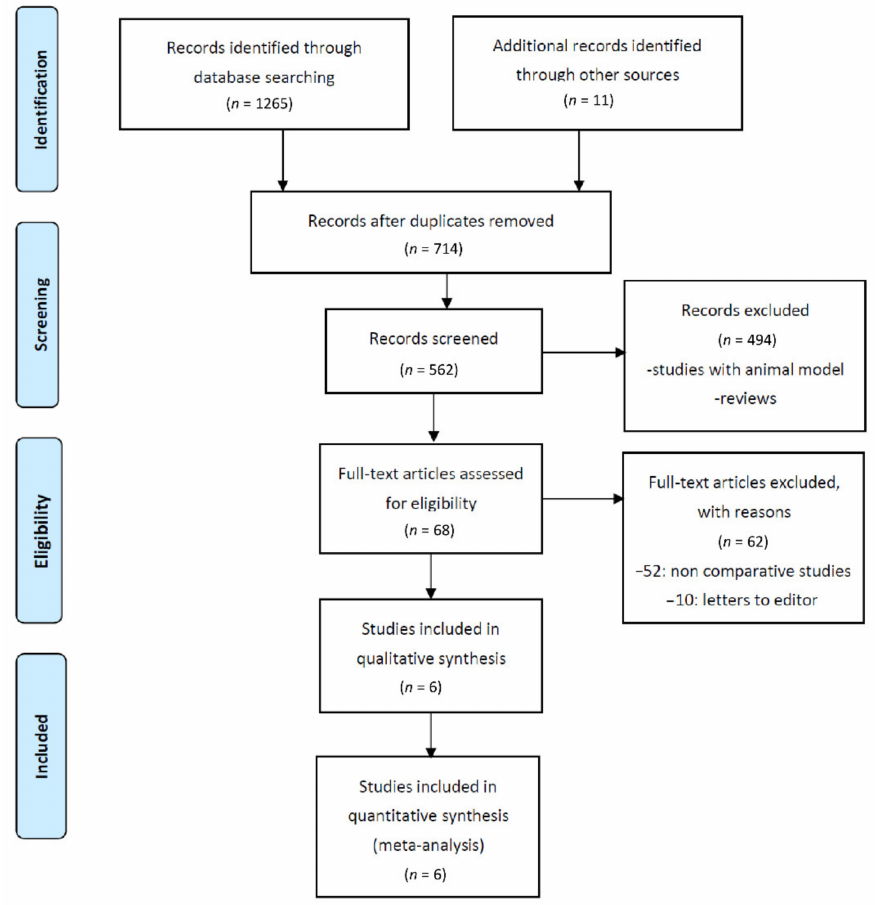
Figure 1. Flow chart of the literature search and selection process. For the Bates et al. study [18], we chose to analyze patients only treated with hypofrac- tionated radiotherapy (HRT). In this study, patients received HRT or standard fractionated radiotherapy (SFRT). In both settings, immunotherapy offered significantly improved OS. In those receiving HRT, immunotherapy improved the 1-year OS from 37.4% to 59.0%. In those receiving SFRT, immunotherapy improved the 1-year OS from 26.1% to 44.9%. The same methodology was applied to Foster et al.’s study [19]. In this study, there were two radiation groups: stereotactic radiotherapy and SFRT. The first group was associated with significantly improved OS, while the second group had significantly reduced